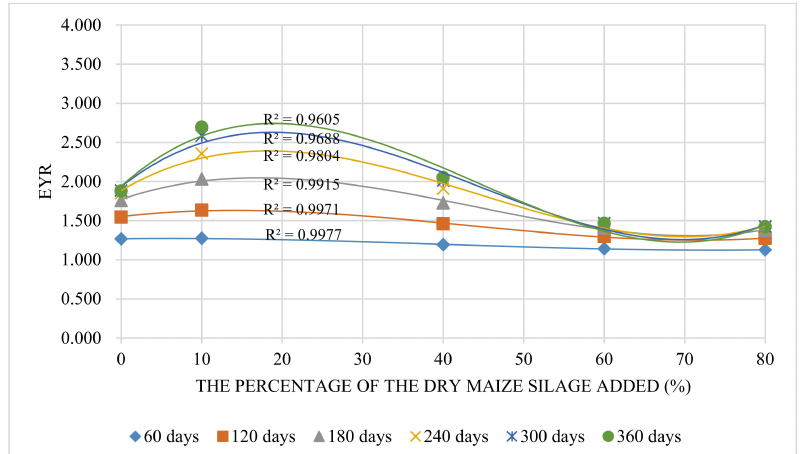
Figure 3. The trend of EYR change with different percentages of maize silage